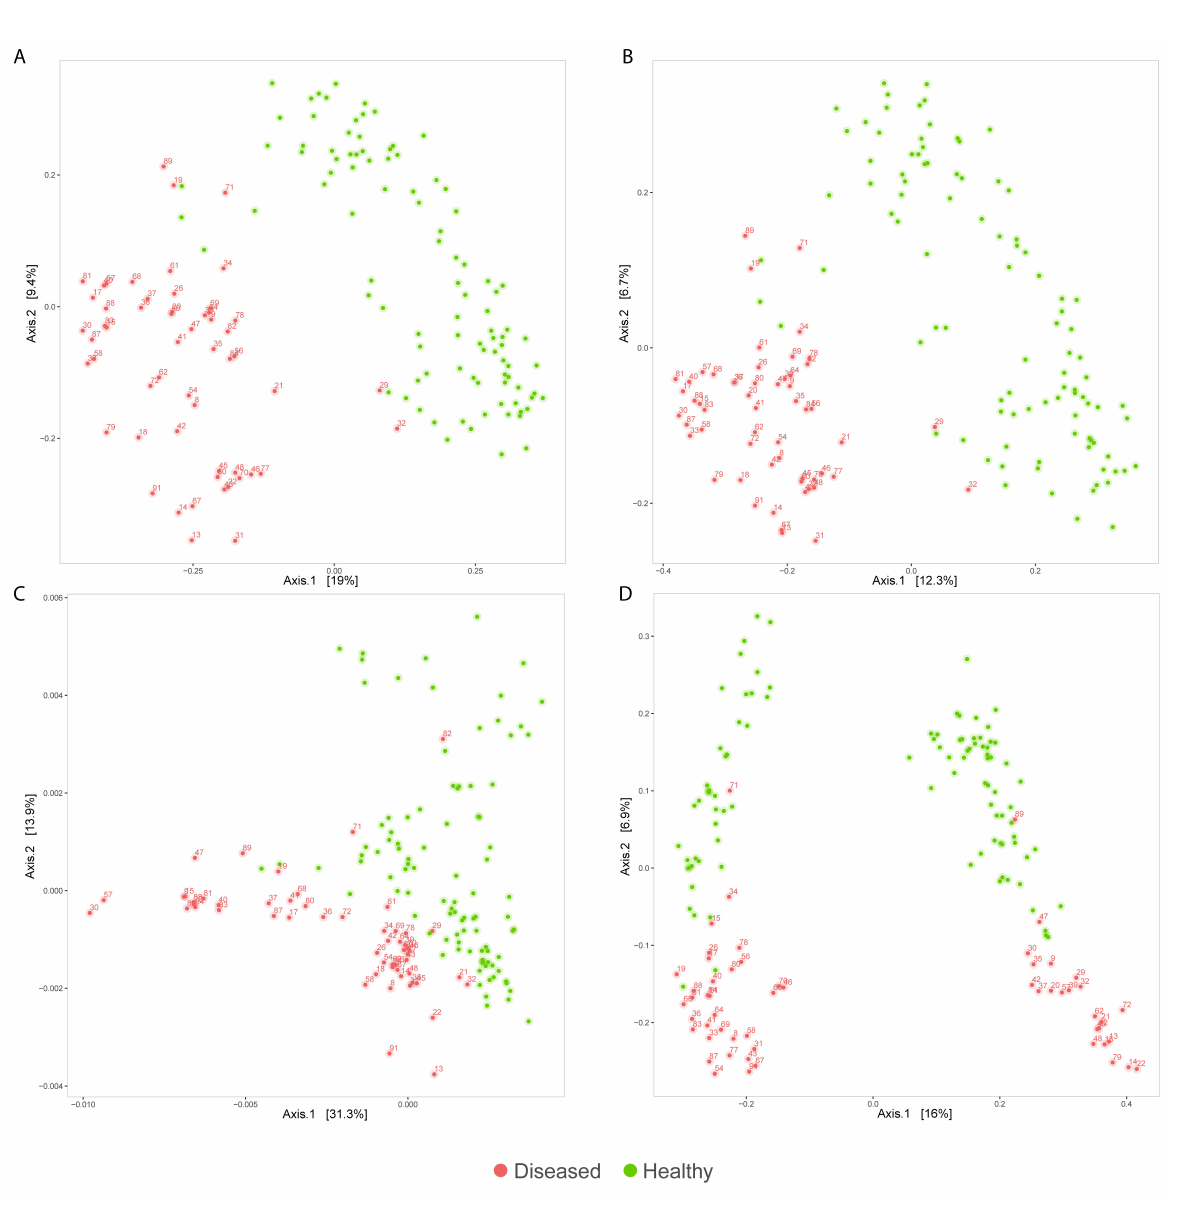
Figure 2. Principal coordinate analysis (PCoA) plots representing the microbial composition of healthy (green) and diseased (red) groups, calculated using Bray-Curtis ( A ), Jaccard ( B ), weighted UniFrac ( C ), and unweighted UniFrac ( D ) diversity measures.